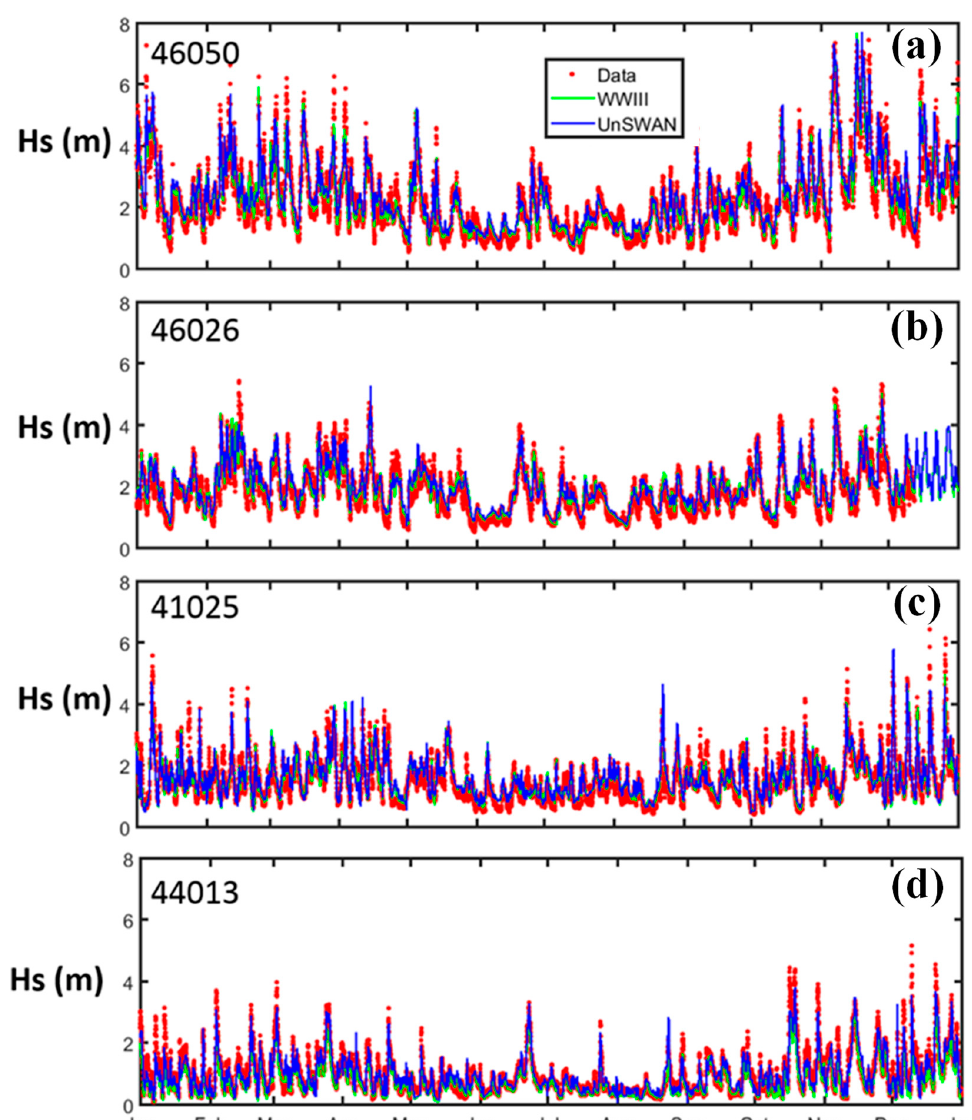
Figure 4. Time series comparisons of significant wave height between model simulations and buoy observations at all four buoys (( a )—46050; ( b )—46026; ( c )—41025; and ( d )—44013) for the baseline-condition simulations in 2009.